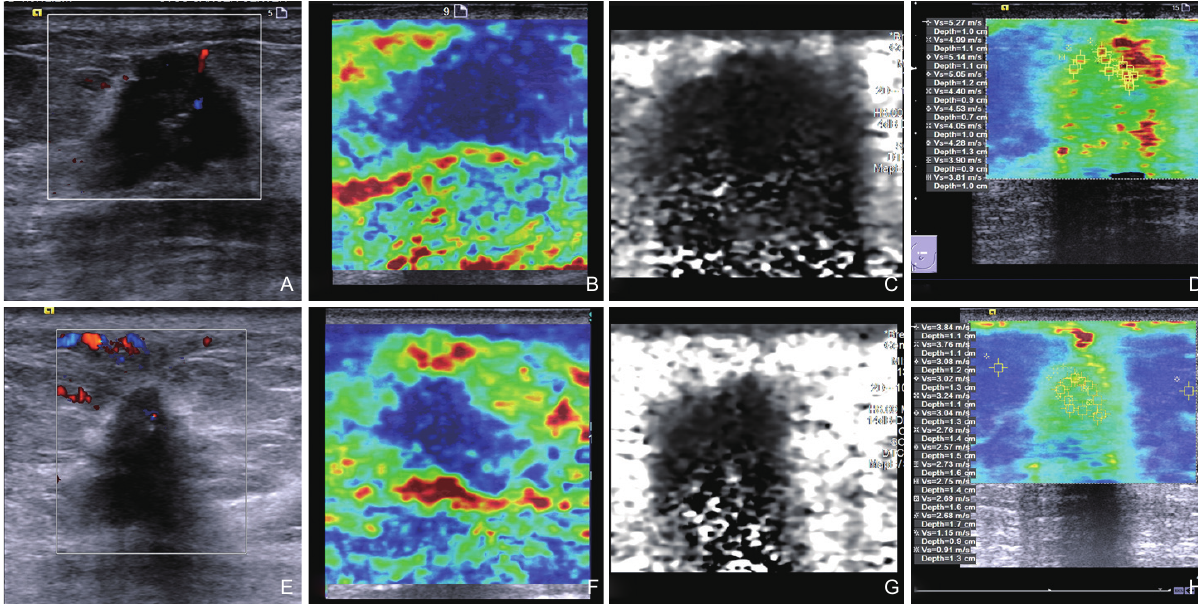
Figure 2 A 44-year-old women with a left breast lesion which was confirmed as invasive breast cancer. Before neoadjuvant chemotherapy, a solid, hypoechoic lesion with well-defined margin was detected with conventional ultrasound (A). The elasticity imaging (EI, B) and the virtual touch tissue imaging (VTI, C) reflected tissue elasticity was hard. In virtual touch tissue quantification (VTIQ), the highest shear wave velocity was 5.27 m/s (D). After two weeks of neoadjuvant chemotherapy, the lesion size decreased and the margin became ill-defined (E). The EI and VTI reflected tissue elasticity was still hard (F and G), while in VTIQ, the highest shear wave velocity decreased to 3.84 m/s